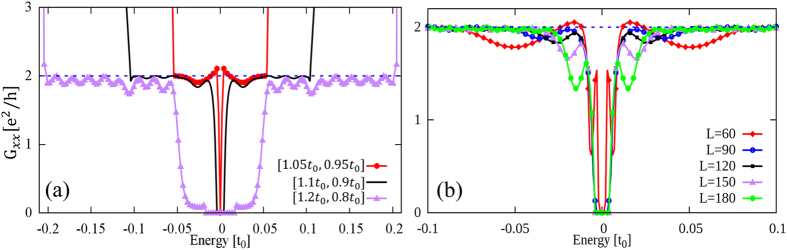
Hopping-energy and sample-size dependence of longitudinal conductances.Longitudinal conductance Gxx of the topological sample given in Fig. 4(a) as a function of the energy of injected electrons: (a) for several typical values of inter-hexagon hopping integrals [1.05t0, 0.95t0], [1.1t0, 0.9t0] and [1.2t0, 0.8t0], where the first (second) inside bracket is for the topological (trivial) region; (b) with several typical system sizes , where the width of the electrodes is fixed at 40a0 and the inter-hexagon hopping integral is fixed at t1 = 1.1t0 and t1 = 0.9t0 for the topological and trivial regions respectively.